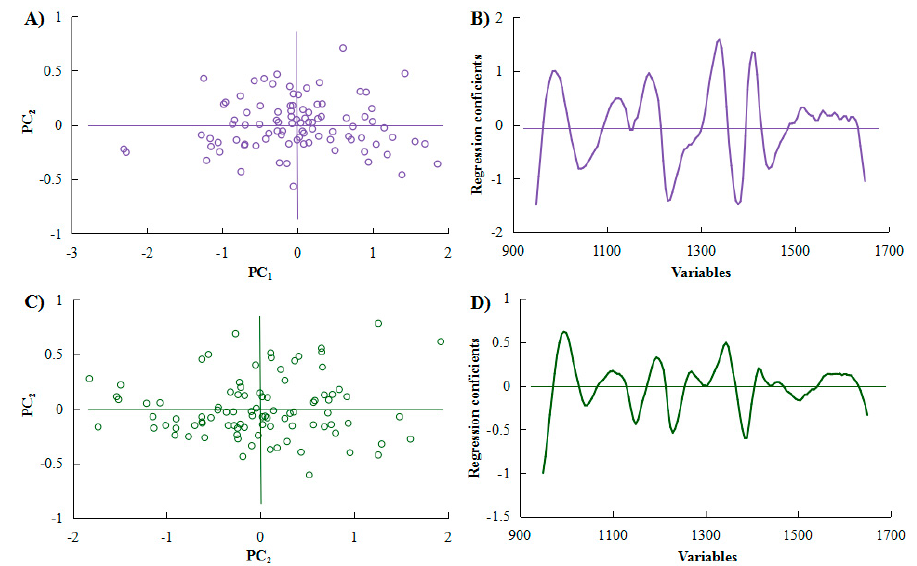
Figure 4. NIRS analysis kernel moisture content of: Camellia gauchowensis Chang ( A , B ); and C. semiserrata Chi ( C , D ).